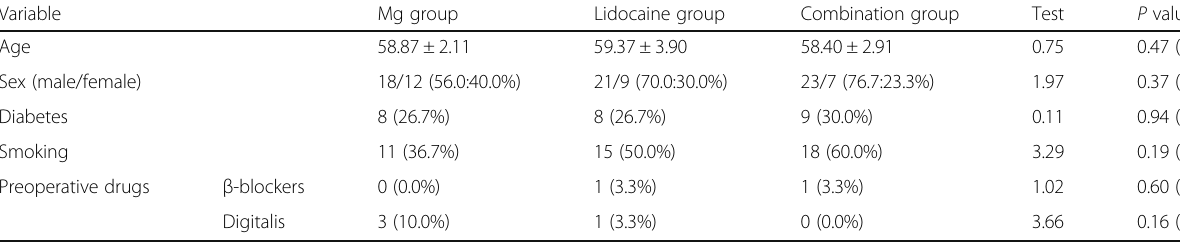
Table 1 Patient characteristics and preoperative risk factors and drugs Variable